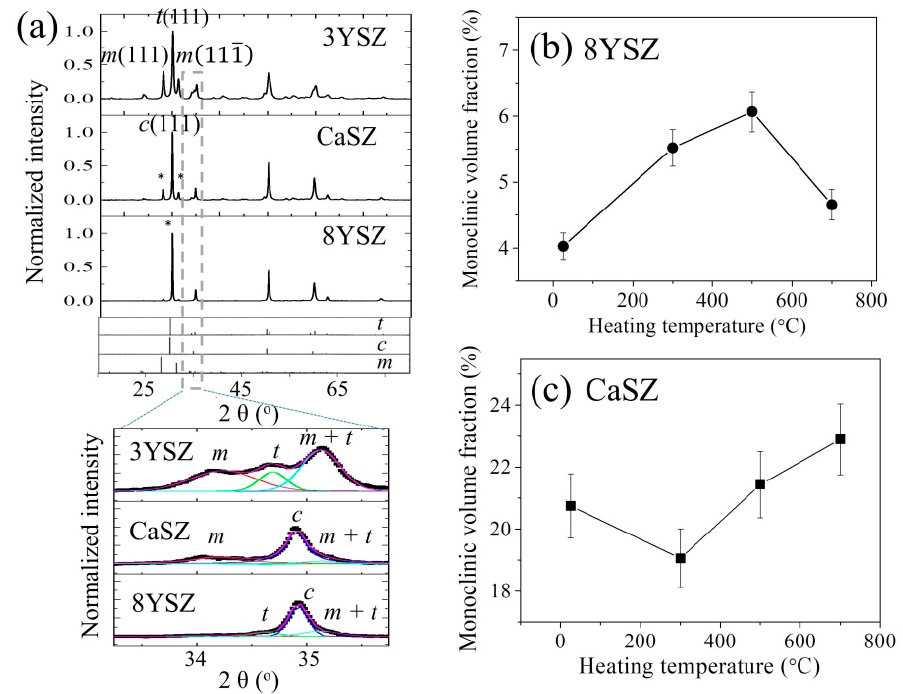
Figure 1. ( a ) XRD patterns for the samples of YSZ (8 mol%), CaSZ and 3 mol% YSZ, with an enlargement of the 2 θ peaks in the range from 33 ◦ to 36 ◦ shown in the bottom inset, and variations of monoclinic volume fraction V m of the samples with annealing temperature for ( b ) YSZ and ( c ) CaSZ. After spectral deconvolution using Lorentzian functions, the monoclinic volume fraction of zirconia in the samples could be calculated according to the peaks in the range from 33 ◦ to 36 ◦ (marked with *; cf. bottom inset in Figure 1a)